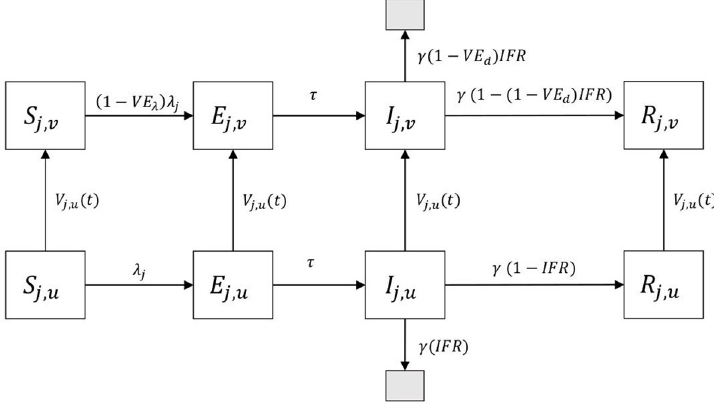
Fig 1. Schematic of SEIR model composed of vaccinated and non-vaccinated compartments. Subscript j represents young, middle, or old age group. Black shaded box represents death